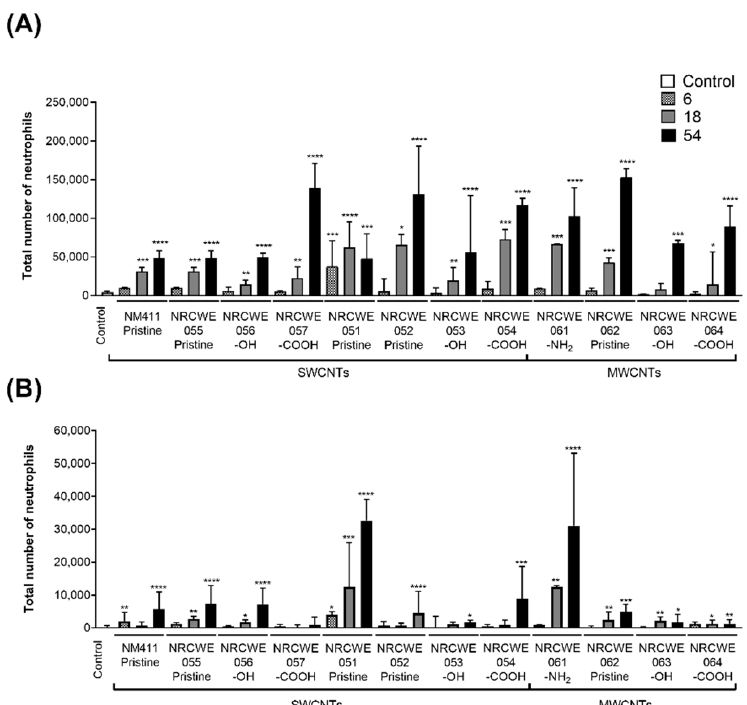
Figure 2. Total number of neutrophils in BALF after exposure to individual SWCNTs or MWCNTs. Data represent median values with interquartile range. Statistically significant differences between exposed animals and controls were determined using the Kruskal–Wallis test with Dunn’s post-hoc. * p < 0.05, ** p < 0.01, *** p < 0.001, **** p < 0.0001. ( A ) Day 1; ( B ) Day 28. Different colors indicate different dose groups: control, 6 µ g/mouse, 18 µ g/mouse and 54 µ g/mouse of CNTs.